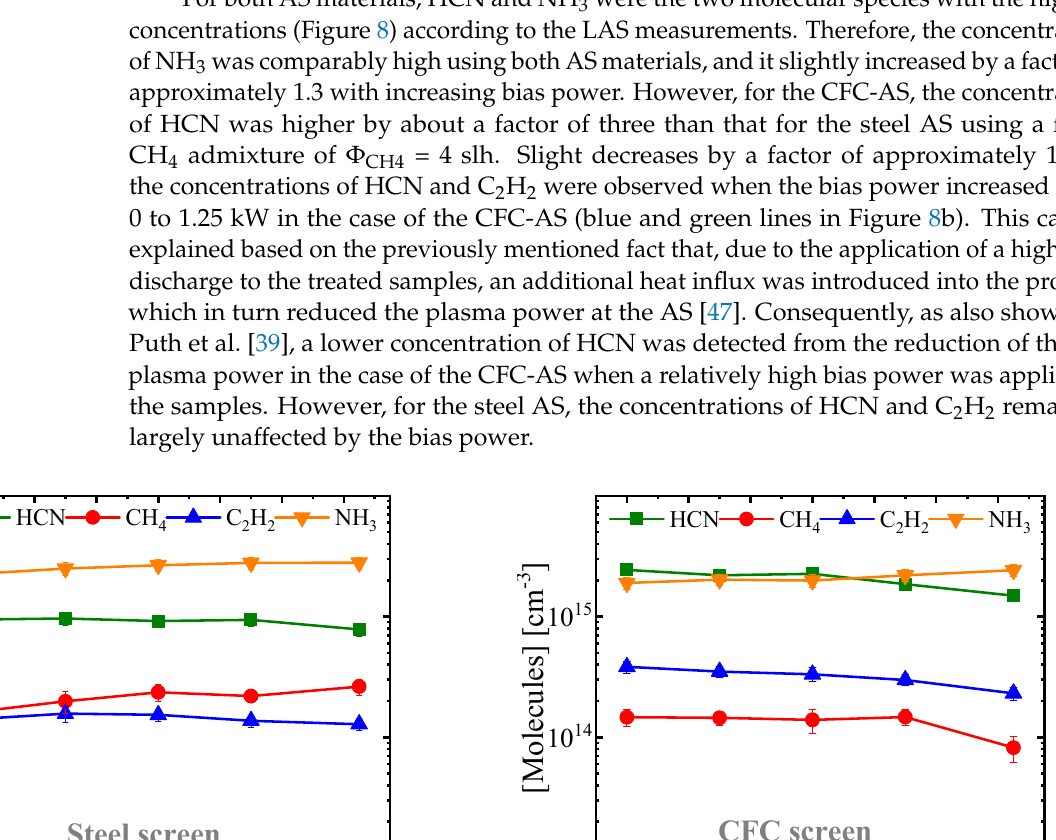
Figure 7. Peak intensities of CN, N 2+ , H, and N as functions of the bias power measured with low-resolution OES during ASPNC treatment using a steel AS ( Φ CH4 = 4 slh) ( a ) and a CFC-AS ( b ) at H 2 :N 2 = 1:1, p = 3 mbar, T = 460 °C, and Φ Total = 80 slh. The intensities are normalized to their respective values at a maximum bias power of 1.25 kW.